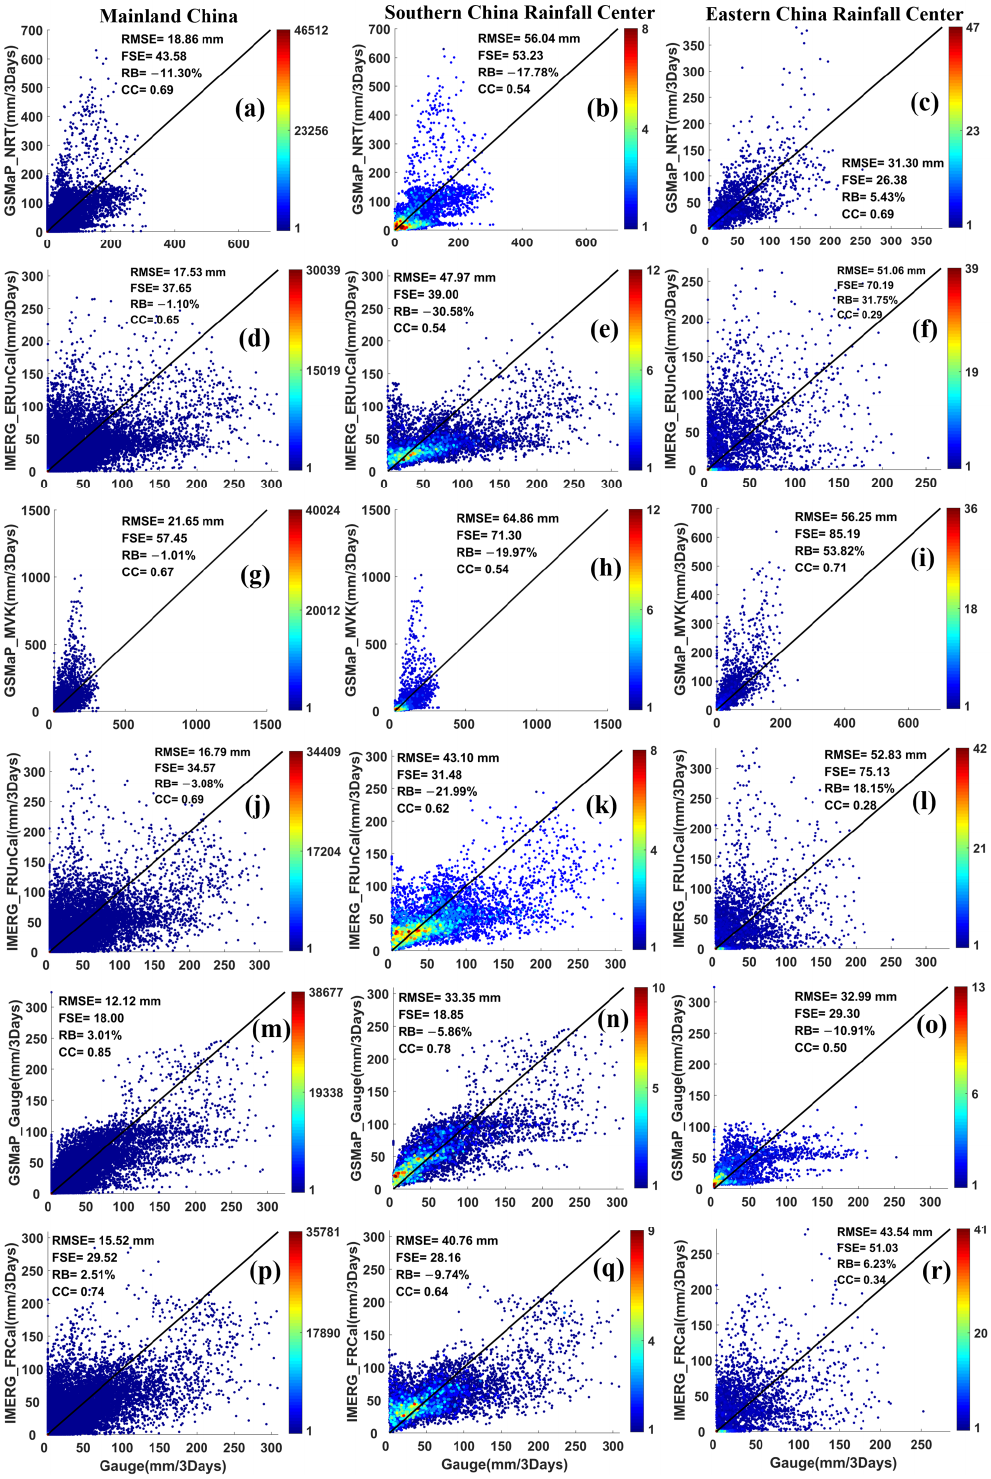
Figure 3. Scatter plots of 72 h of accumulated precipitation between satellite products (the satellite-only GSMaP and IMERG products for ( a – l ) and their gauge-corrected products for ( m – r )) and gauge observation over different areas during typhoon Mangkhut for rainfall centers over mainland China (the 1st column), southern China (the 2nd column), and eastern China (the 3rd